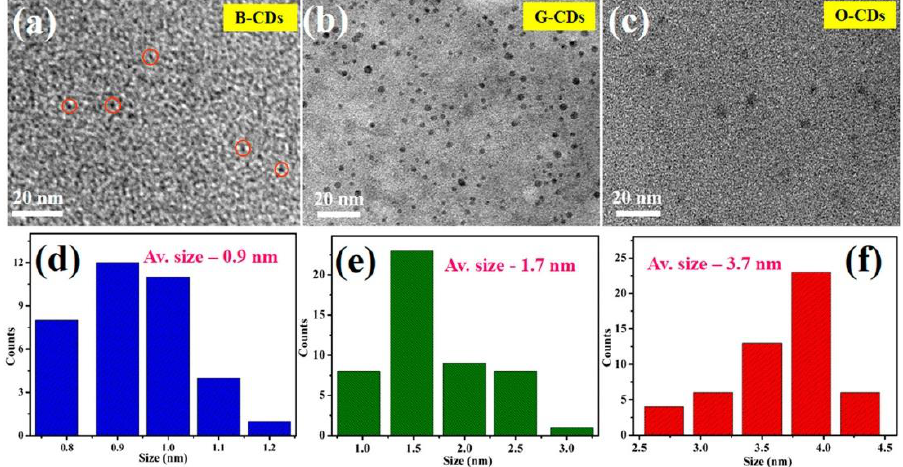
Figure 13. ( a – c ) HR-TEM images of blue, green, and orange color emissive CDs and ( d – f ) their size distributions histogram. (Reprinted from [118]; with the permission of the American Chemical So- ciety).